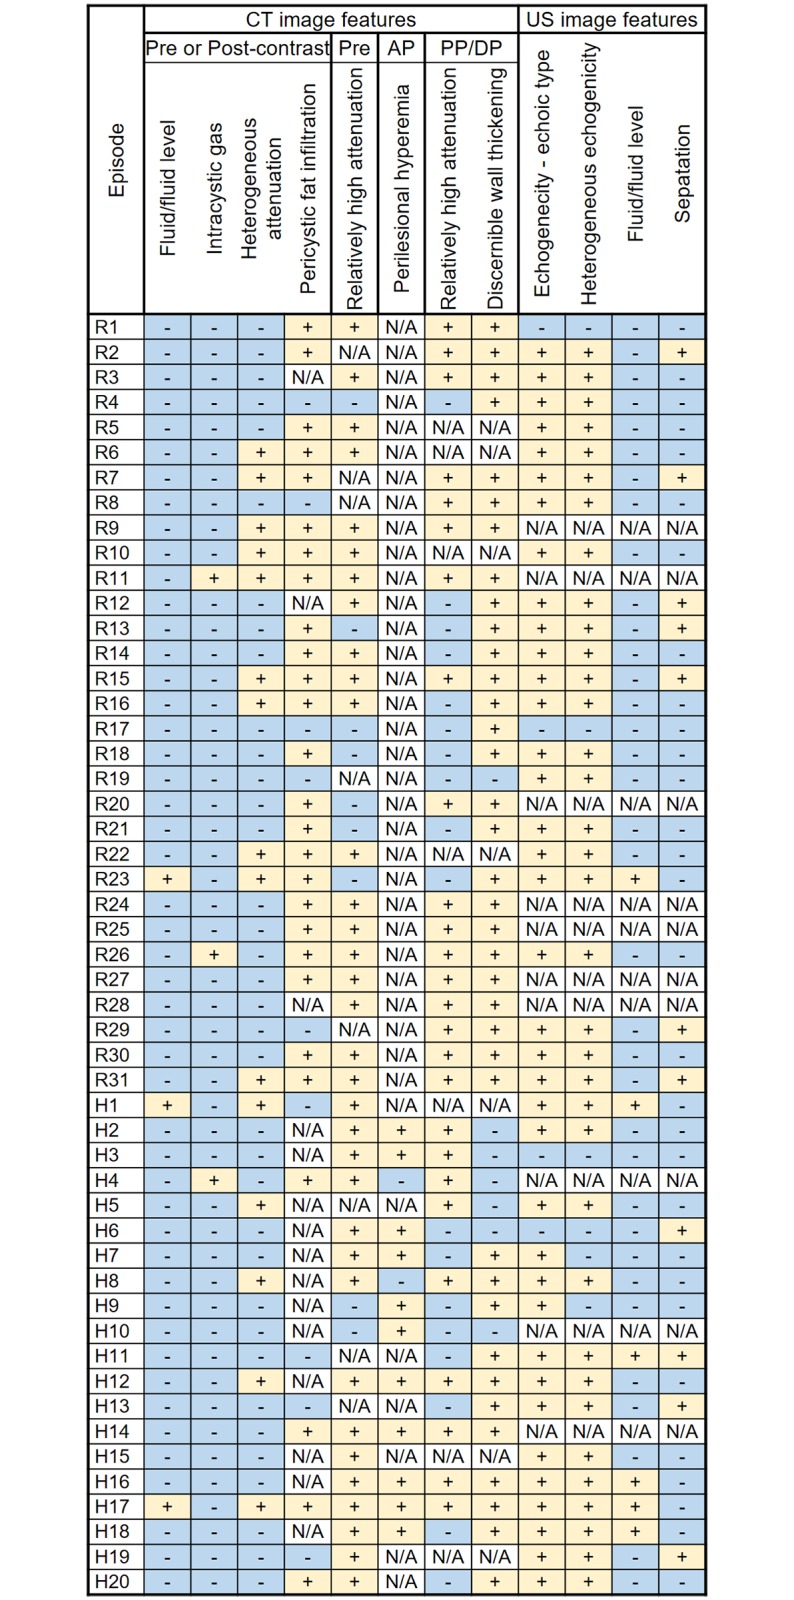
Mapping for CT imaging features in 51 episodes of cyst infection in 43 patients with ADPKD.Note: ADPKD = autosomal dominant polycystic kidney disease; Pre = pre-contrast images; AP = arterial phase images; PP = portal venous phase images; DP = delayed phase images; R, renal cyst; H, Hepatic cyst.